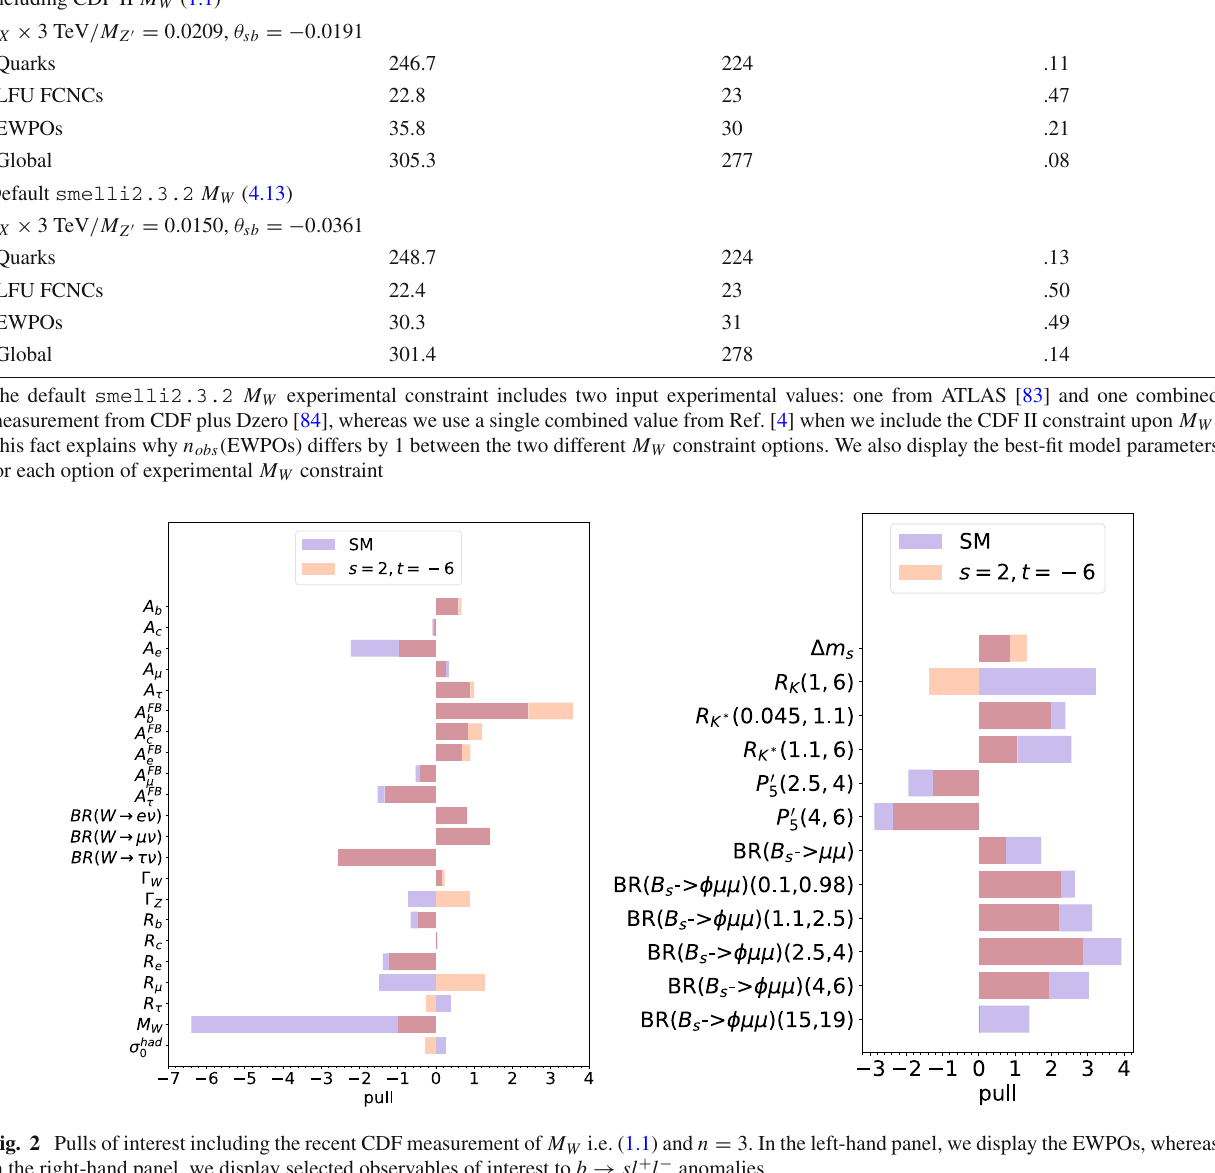
Table 4 p values for s = 2 , t = − 6 for the two different different constraints upon M W and n = 3. Category χ 2 n obs p value Including CDF II M W (1.1)